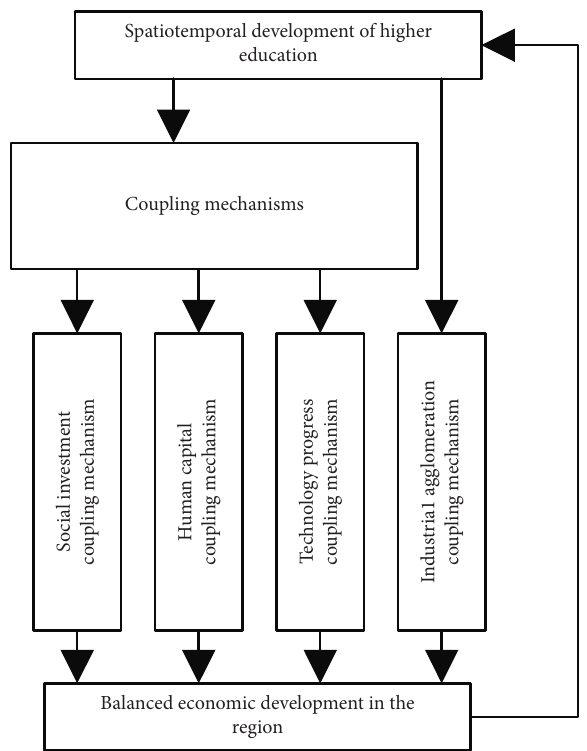
Figure 6: Principle of how the four mechanisms affect regional economic